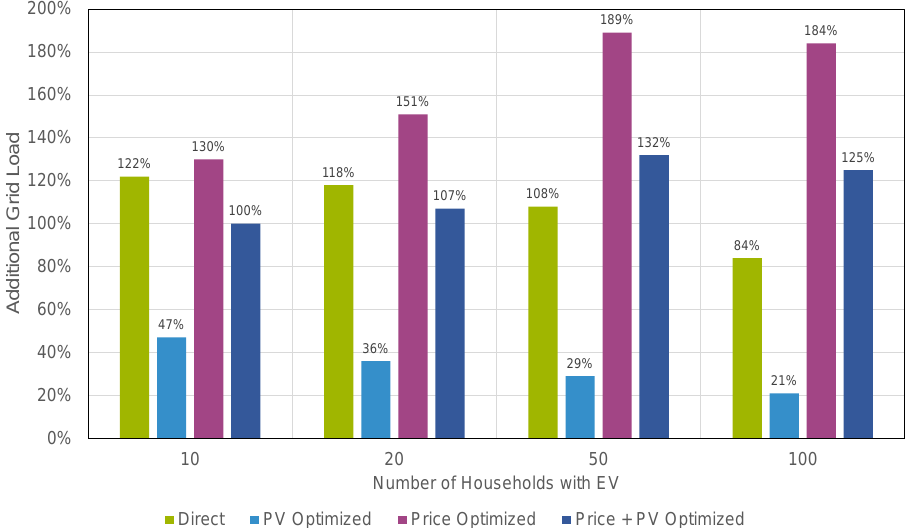
Figure 23. Largest 1% values of additional grid load for each charging configuration and variation of the number of households with EVs .